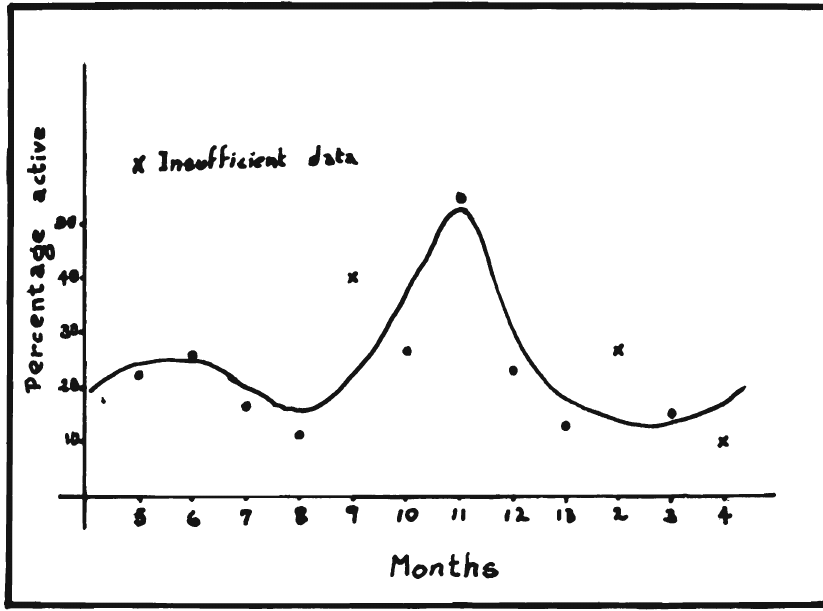
Fig. 3. Monthly relative frequency of maturity indices 3 to 7 fish in the popu